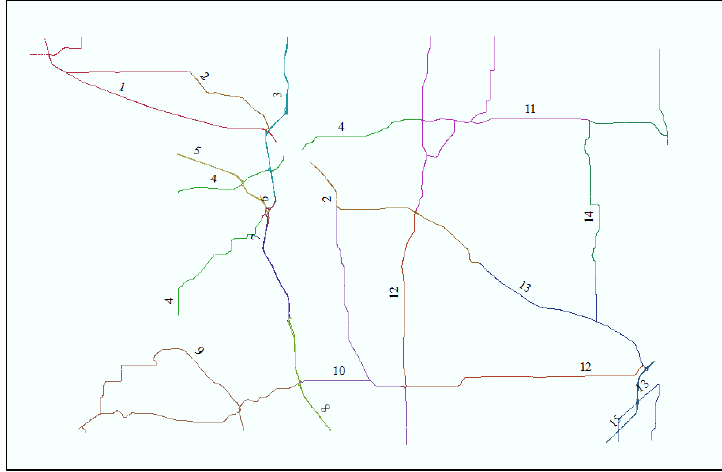
Figure 12. Patrol section map in Columbia County, WI,